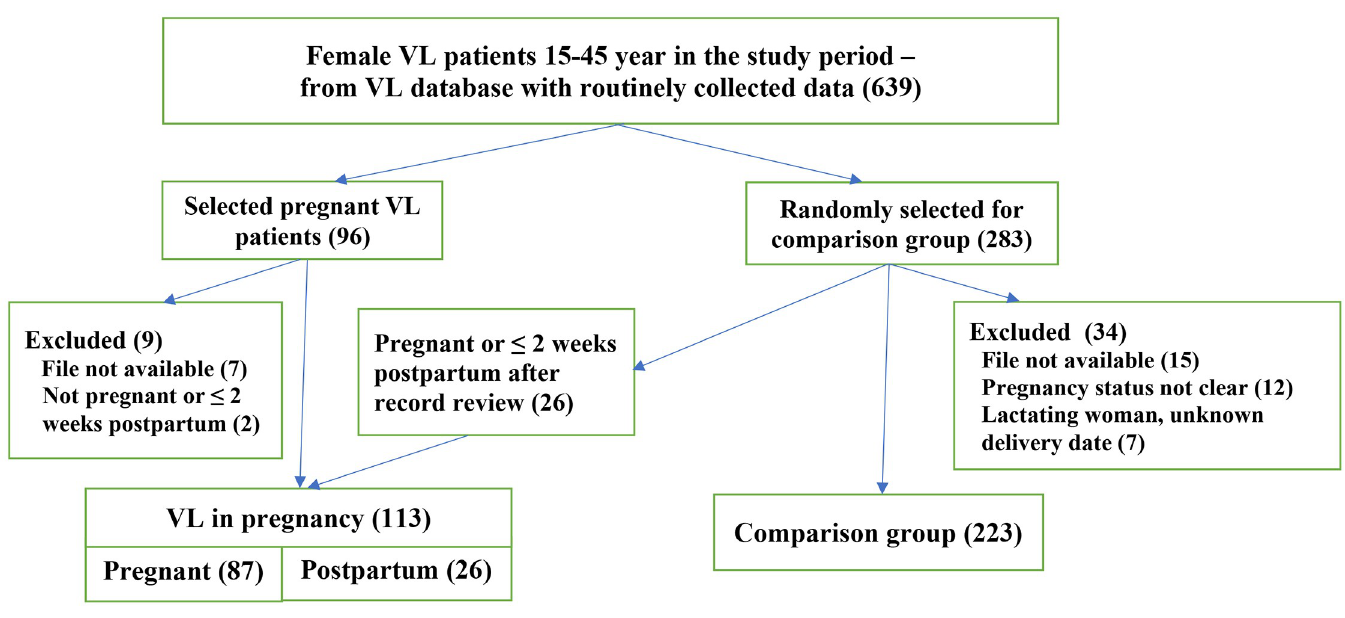
Fig 1. Study flow